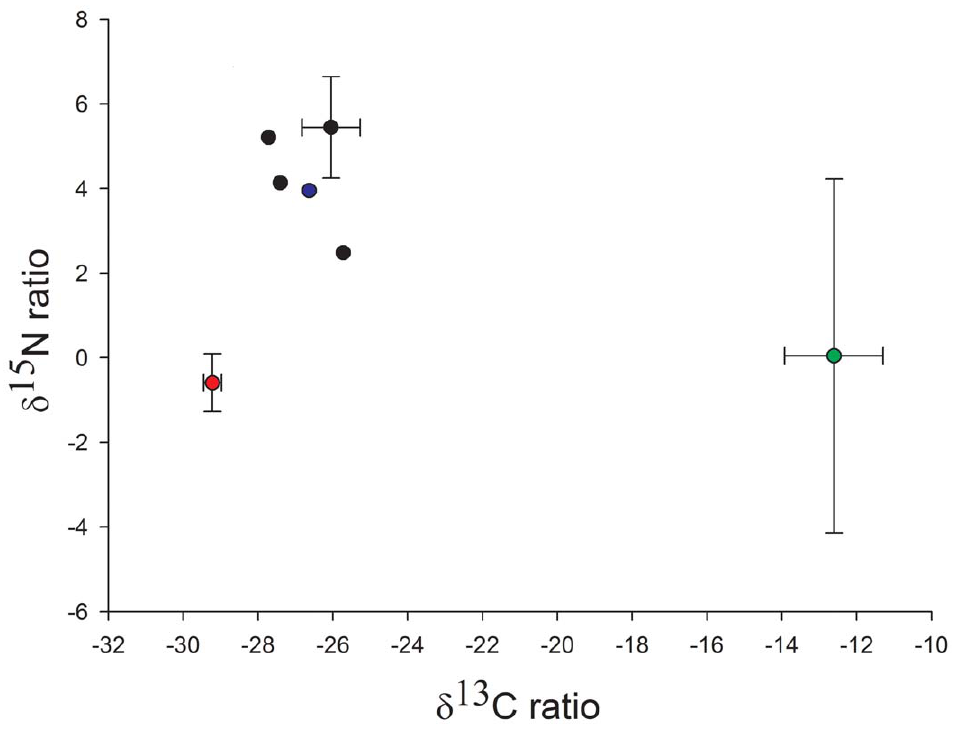
Figure 1. Example of isotopic values for food items found in one field where mole-rats were sampled. Green indicates average grass signature ( 6 SD), red average clover signature ( 6 SD), blue average tuber (only one species in this field) and black dots bulb and corm species ( 6 SD).